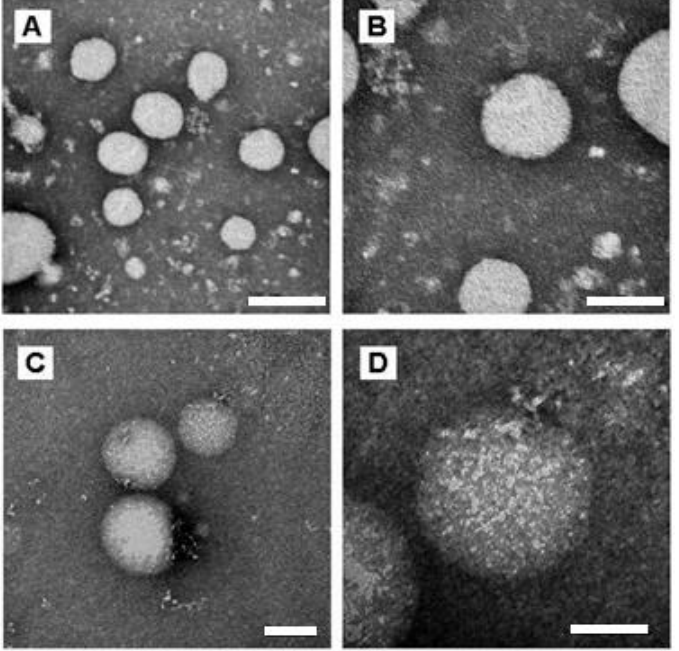
Figure 2. TEM images of empty Eudragit NCs ( A , B ) and Eudragit NCs containing nicotine ( C , D ) at different magnifications—( A , C) 150,000 × ; ( B , D ) 300,000 × . Scale bars of ( A – C ) 200 nm ( D ) 100 nm. Table 1. Results for nanocapsule stability for 0, 7, 15, 30 and 90 days. ZP = zeta potential; PdI = polydispersity index; EN = empty nanocapsules; NNC = nicotine containing